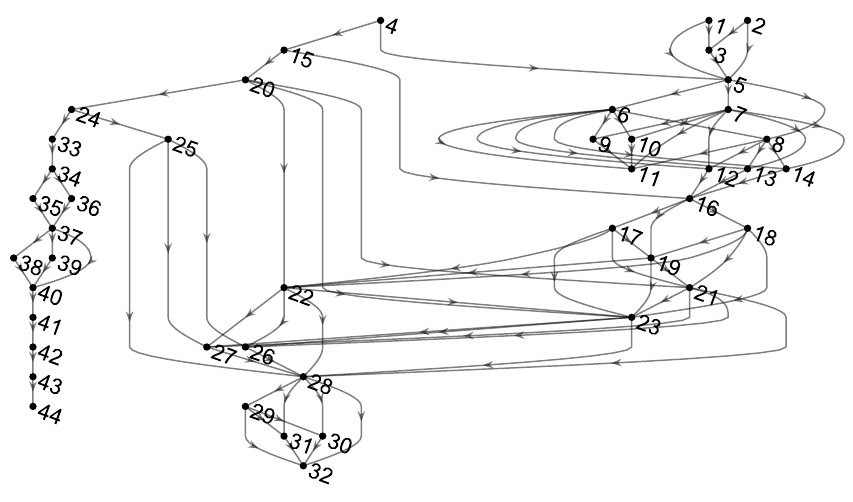
Figure 2. Task dependency graph.